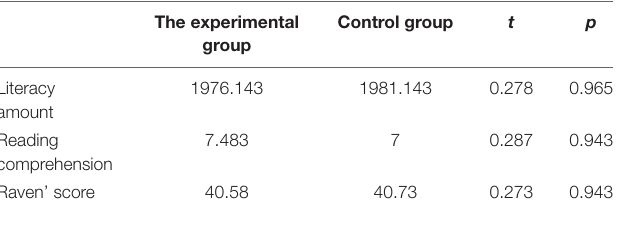
TABLE 1 | The homogeneity test of the experimental group and control group. The experimental